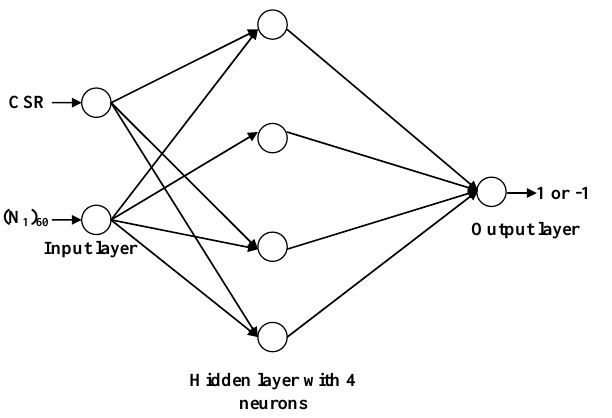
Figure 3. MSE versus Epochs for ANN models. Fig. 3. MSE vs. Epochs for ANN